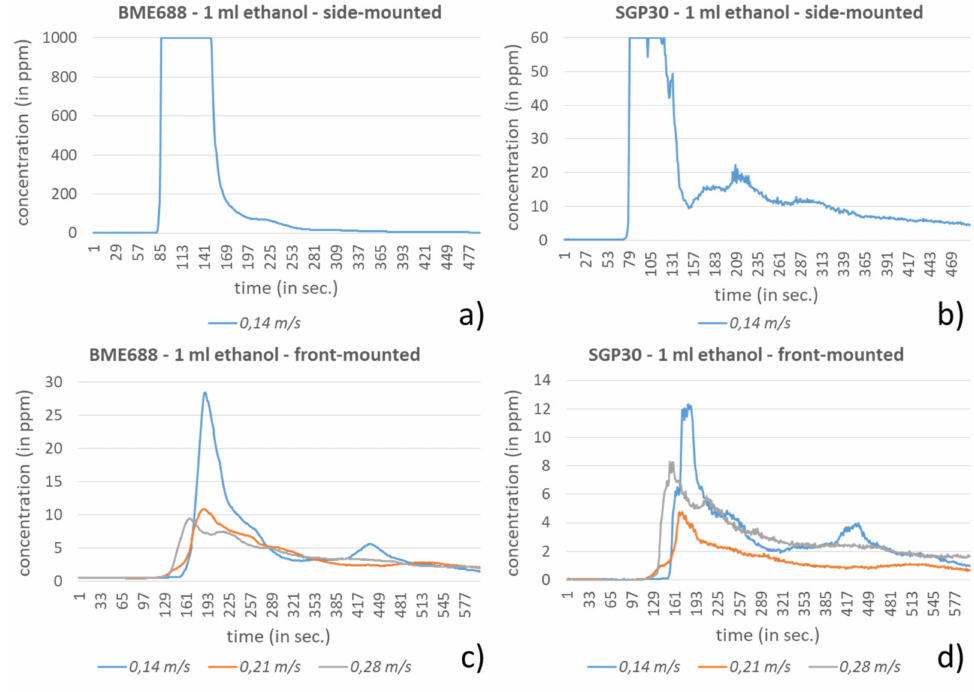
Figure 19. Results for the detection of 1 mL ethanol during passing by with the H20-robot in different speed levels and with front- and side-mounted sensor node. ( a ) Response of the side-mounted BME688 and ( b ) SGP30. ( c ) Response of the front-mounted BME688 and ( d )